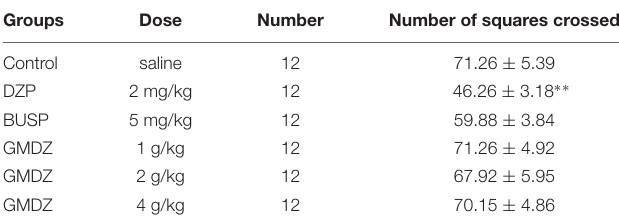
TABLE 1 | Effects of GMDZ decoction on the open field test in mice. Groups Dose